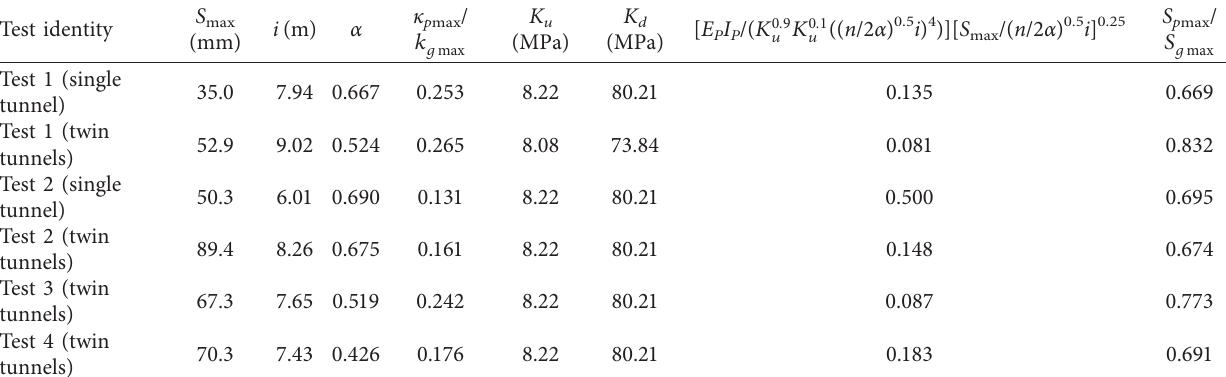
Table 4: Summary of the calculation parameters of the four centrifuge model